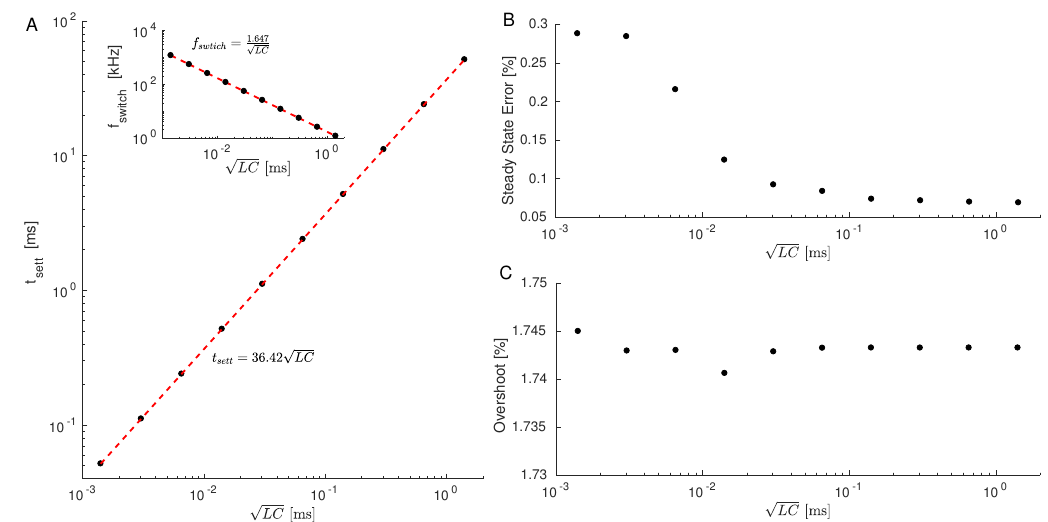
√ LC and fixed Figure 6. ( A ) Black symbols: Settling time of the buck converter with different values of R = 20 Ω , preserving the value of γ = 0.3536. Red line: Linear fit of the simulation points. For this plot, we chose inductance values in the range L = [ 20 µ H 10 mH] and a capacitance C = L /50 F. Settling time was calculated as the time it takes to the system to evolve from ( v , i , y ) = ( 0,0,0 ) to the point in which the error doesn’t leave the ± 2% band. Inset: Switching frequency resulting from the hysteresis √ LC reported in the main figure (black symbols). Red band in Equation (33) for the different values of line depicts the fitted function reported in the text box; ( B ) Average steady state error calculated as the √ LC reported mean value of the error after the settling time; ( C ) percentage overshoot for the values of √ LC . in panel ( A ). For each simulation point, the system is evolved during a time span of T = 200 Other details as in Figure